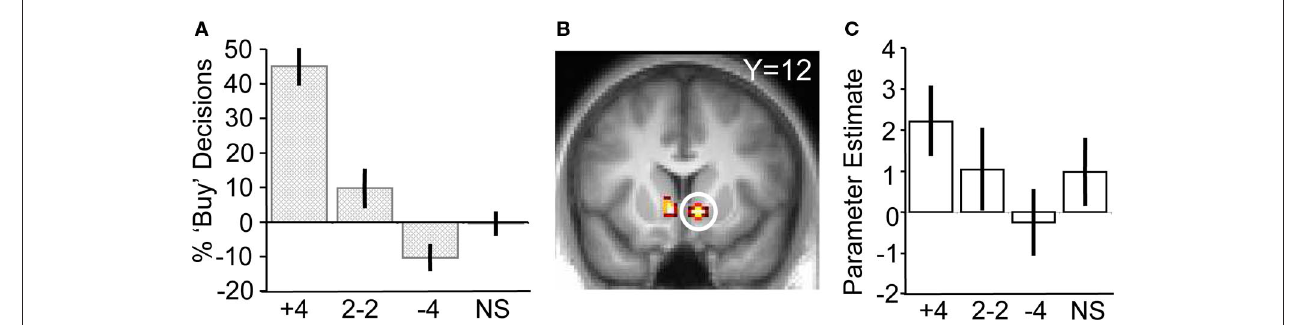
Figure 3 | responses to social information in the absence of stock information. (A) Behavioral changes in buy decisions for the scrambled stock as a function of human social information (one-way ANOVA, F (3,17) = 18.24, p < 0.001).